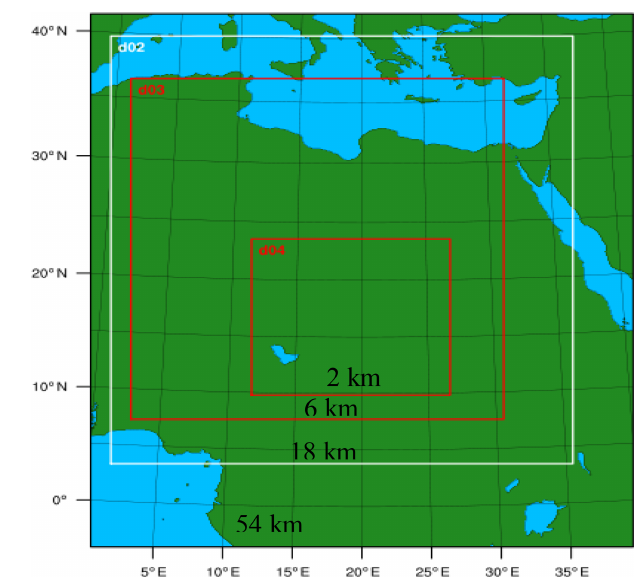
Figure 9. WRF domain configuration for the Bodélé Depression dust storm case shown in Fig. 11 (Pokharel, 2016). The do1, do2, do3, and do4 represent domains of 54, 18, 6, and 2km resolutions, respectively.